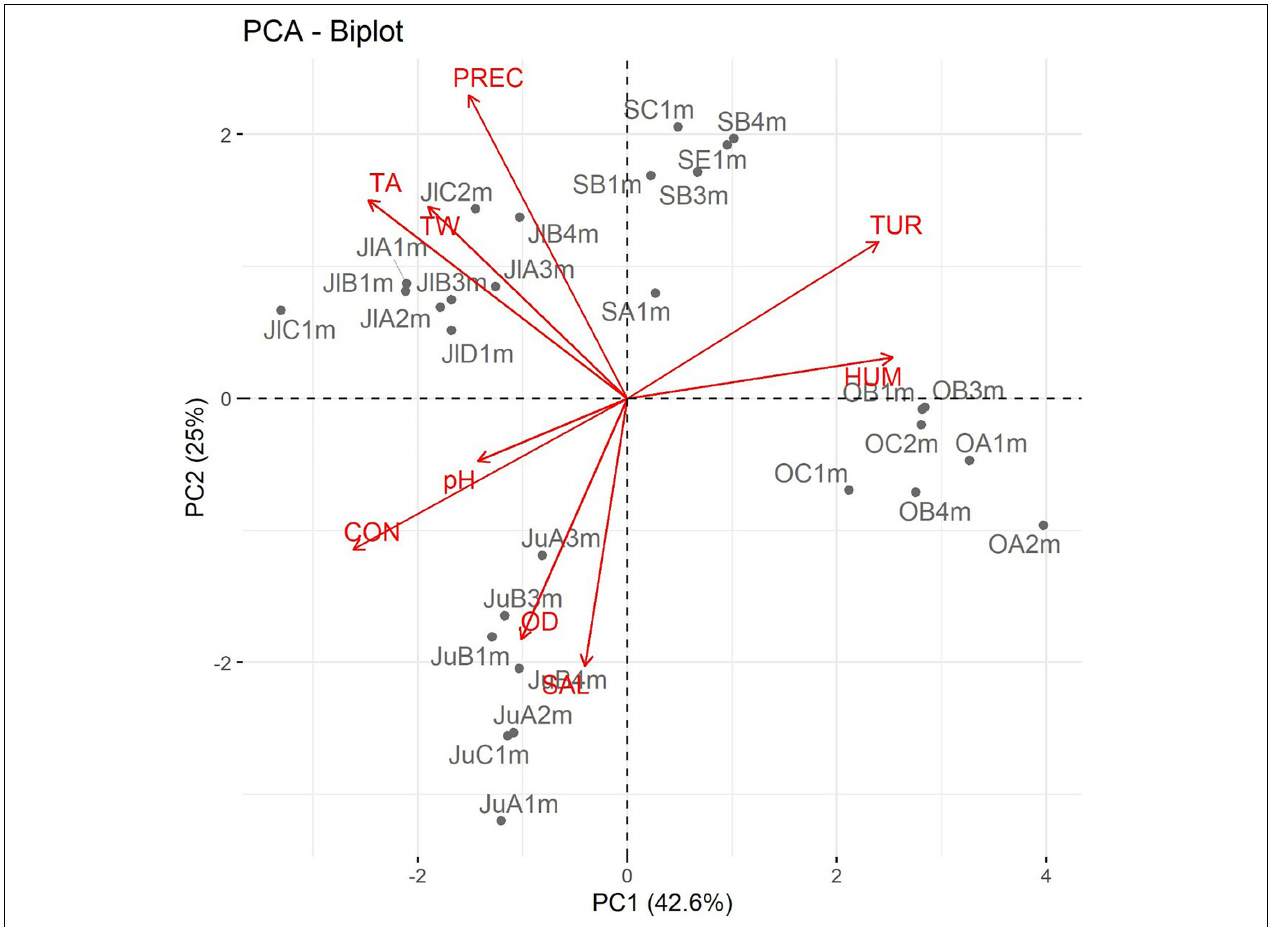
FIGURE 3 | Principal component analysis (PCA) of the physicochemical and environmental parameters; each vector represents a variable, and the correlation of two variables is reflected by the angle between the two corresponding vectors. Abbreviations: WT: water temperature; DO: dissolved oxygen; CON: electrical conductivity; TUR: turbidity; TA: air temperature; HUM: relative humidity; PREC: rainfall; and SAL: Salmonella . Code of the isolated Salmonella strains: First and/or second letter correspond to the sampling month (Ju: June; Jl: July; S: September; and O: October); the second and/or third letter indicate the sampling site (A, B, C, D, or E); and the penultimate number and letter refer to the depth (1, 2, 3, or 4